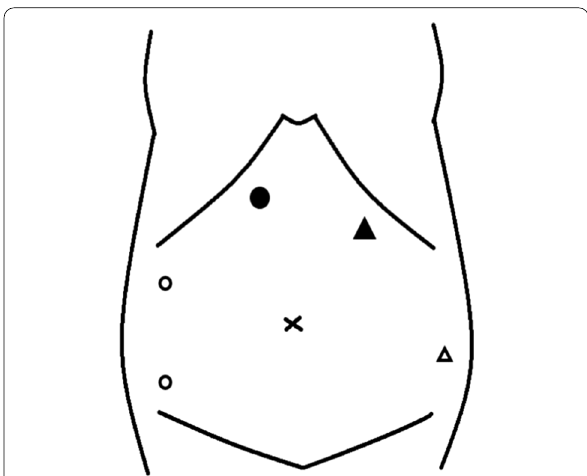
Fig. 3 Trocar placement in first and second operations. ● A 12-mm trocar in the first operation. 〇 A 5-mm trocar in the first operation. ▲ A 12-mm trocar in the second operation. △ A 5-mm trocar in the second operation